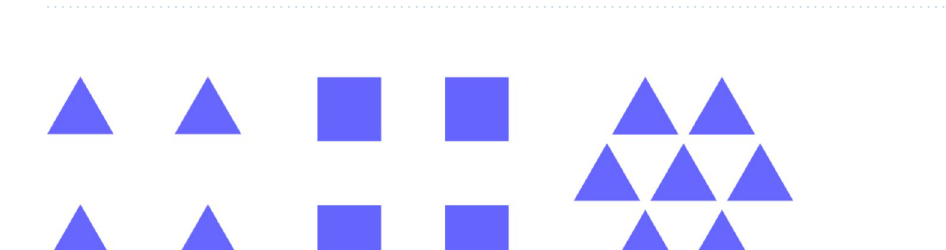
Table 1. The combinations of prisms, lattices, and the resulting overall degree of discrete rotational symmetry n for all the arrays that we consider.